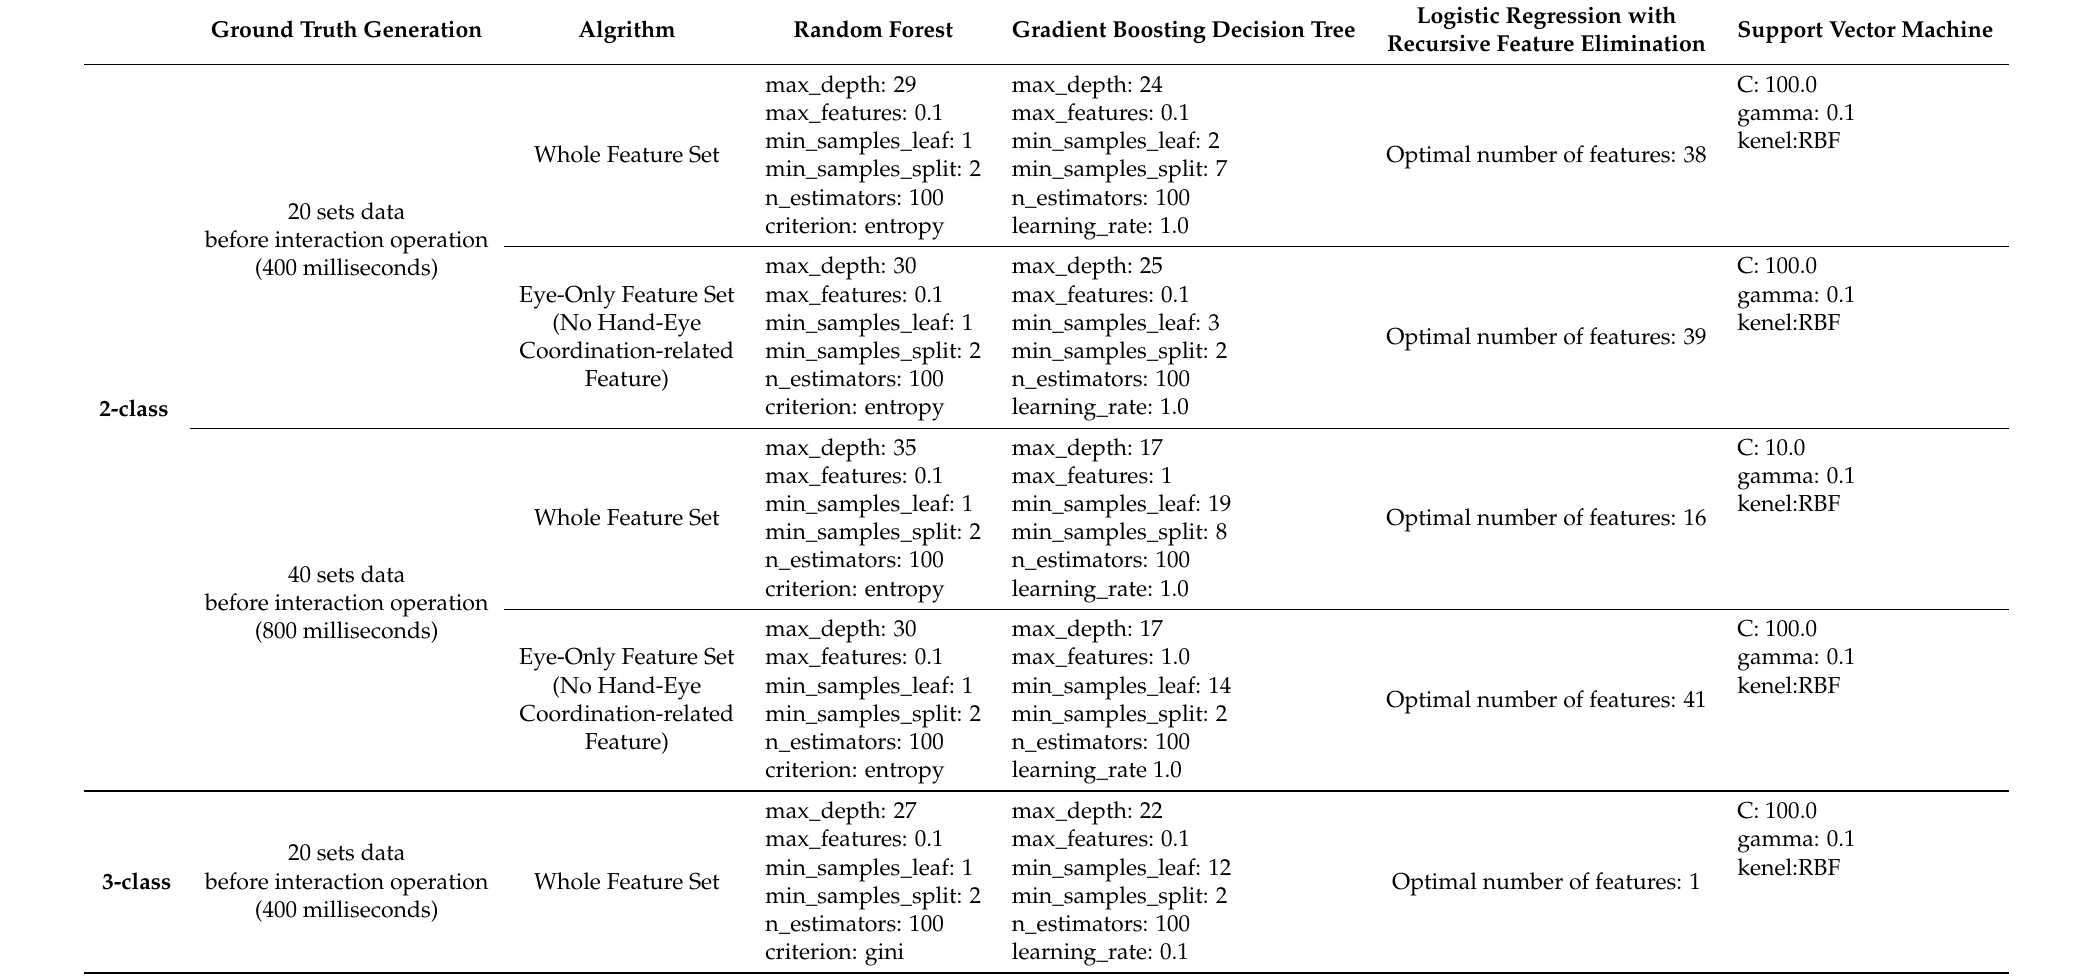
Table A1. The optimal parameters of each classifier are selected by grid search. Ground Truth Generation Algrithm Random Forest Gradient Boosting Decision Tree